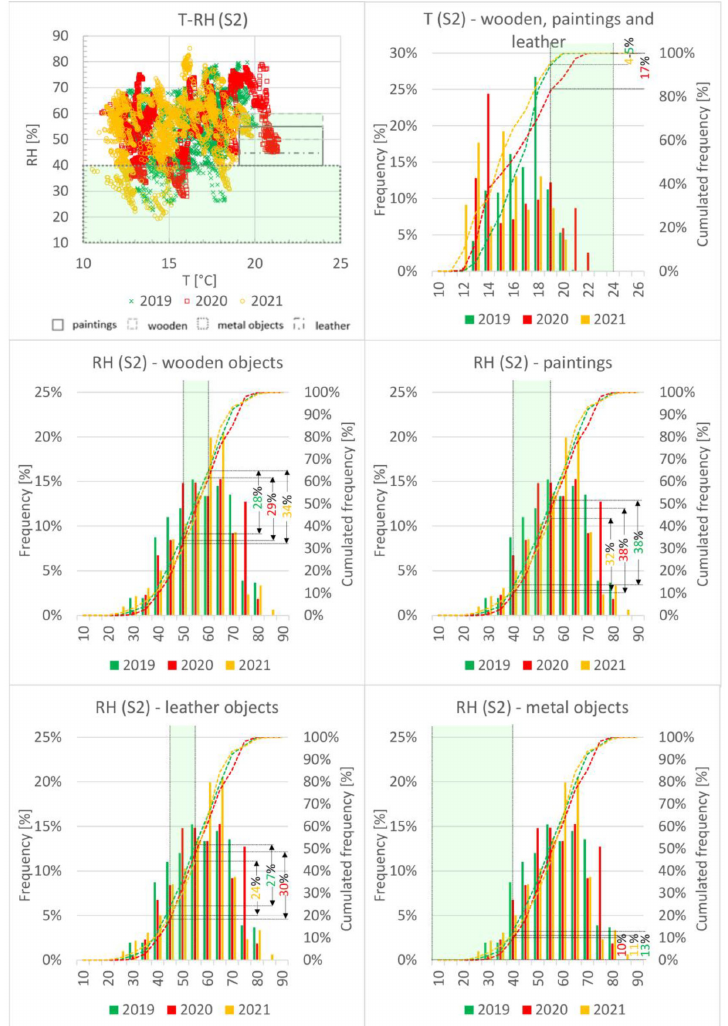
Figure A1. Scatterplot and frequency distribution comparison of indoor climate data (datalogger S2) from March to May 2019, 2020 and 2021 with respect to the conservation range (the green area) proposed by UNI10829 for different